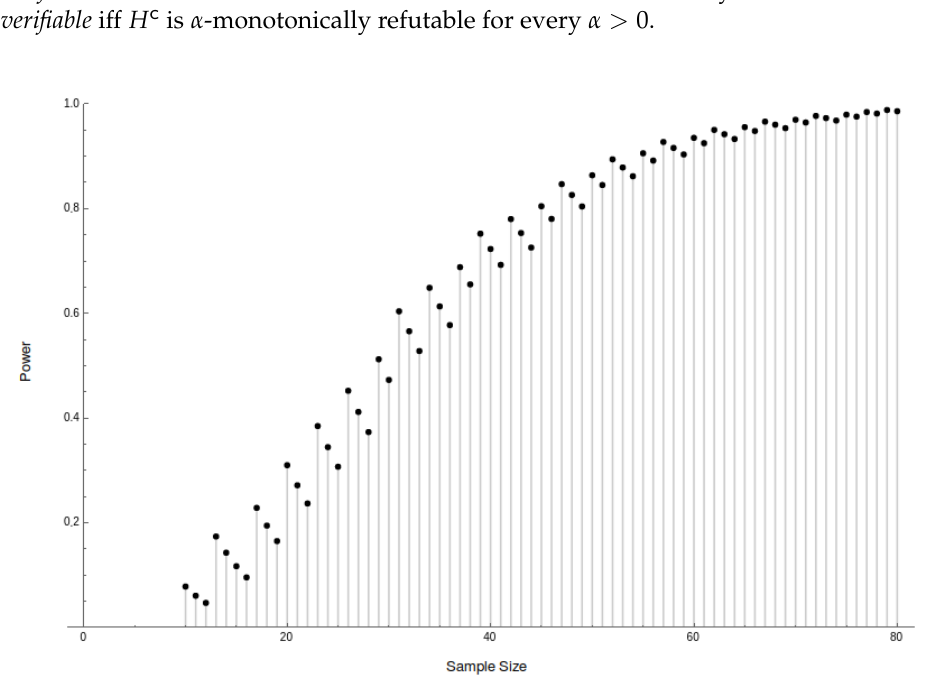
Figure 2. Diachronic plot of power of typical test of the null hypothesis that a coin is not head-biased, when p ( H ) = 0.775. The plot exhibits the characteristic “saw-tooth” shape identified by Chernick and Liu [23]. Note that the drops in power are significant e.g., > 0.07 between sample sizes 31 and